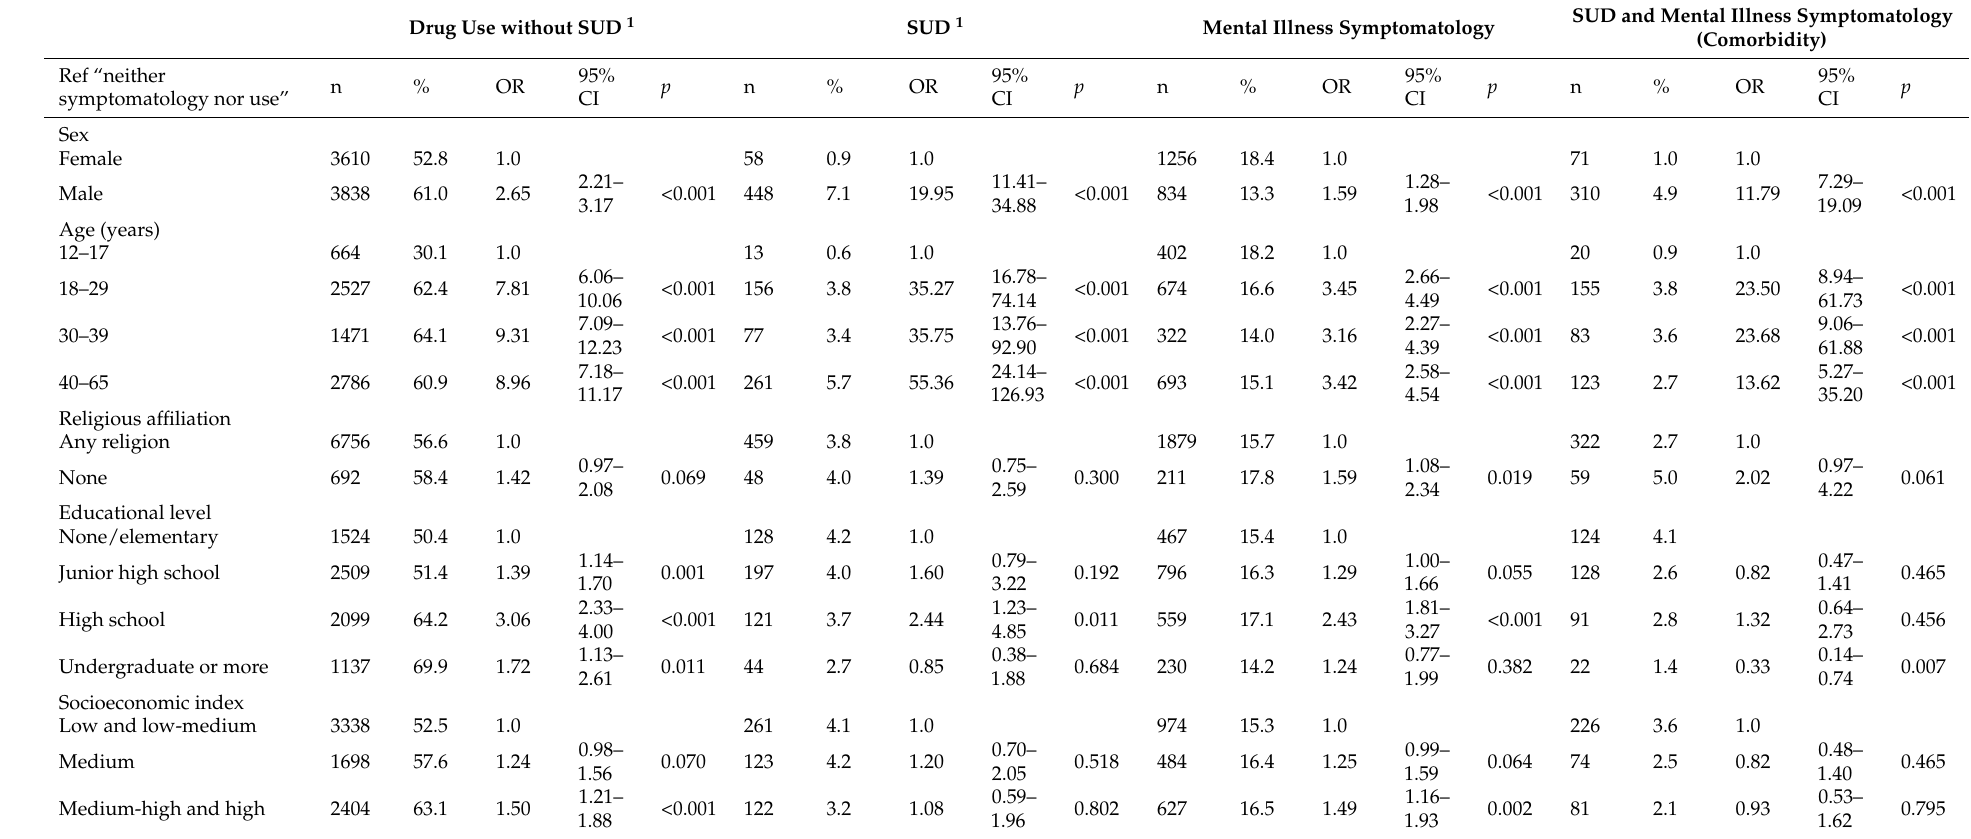
Table 4. Multinomial logistic regression model of SUD and mental illness